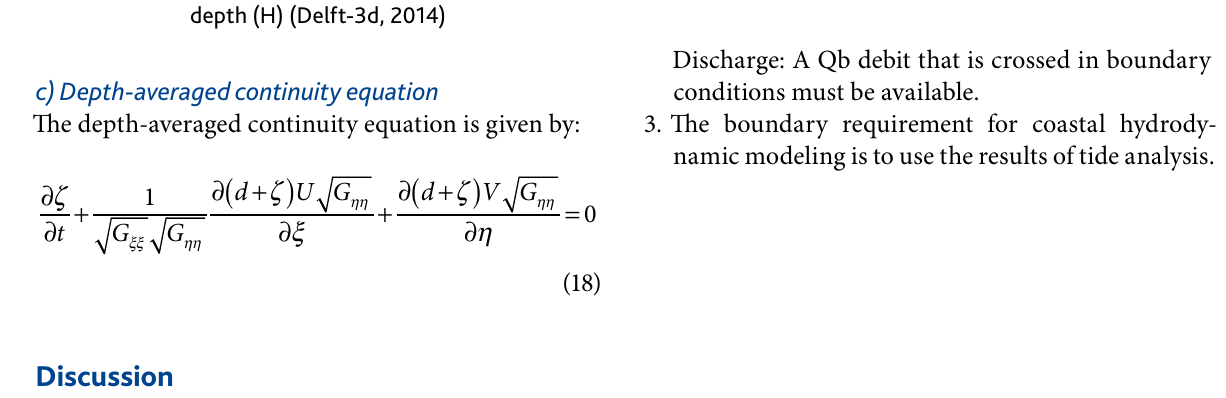
Figure 7. Definition of water level (, depth (h) and